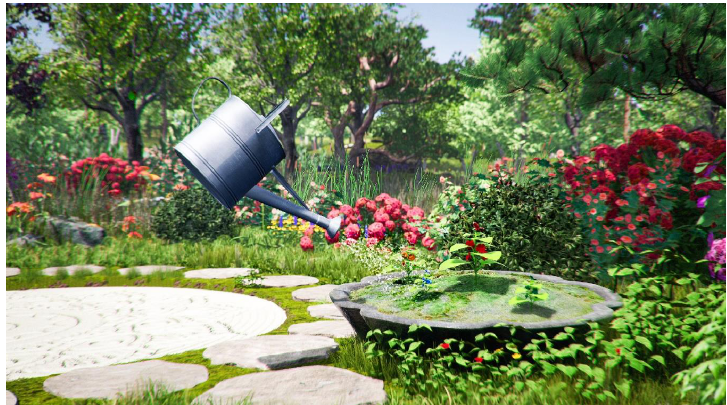
Figure 2. Virtual garden at the final stage of therapy.